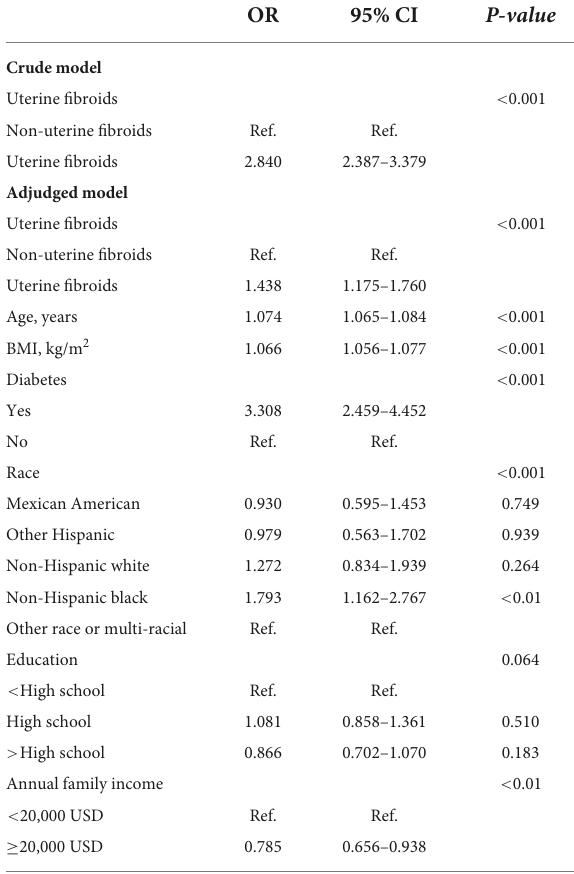
TABLE 2 Logistic regression analysis of uterine fibroids and cardiovascular diseases (CVDs) in National Health and Nutrition Examination Survey (NHANES)